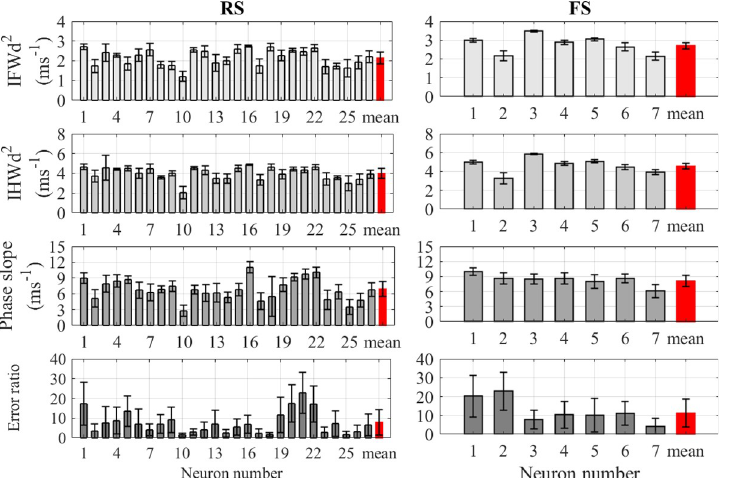
Fig 2. The AP rapidity calculated using the four quantification methods for cortical neurons. Comparison between the rapidity quantification methods for RS pyramidal cortical neurons (left) and FS cortical neurons (right). The units for IFWd 2 , IHWd 2 , and phase slope are in ms -1 while the error-ratio is dimensionless. Error bars indicated standard deviations for each neuron. The red bar at the end of each figure indicates the pooled mean value for all neurons and its error bar indicates the pooled standard deviation.